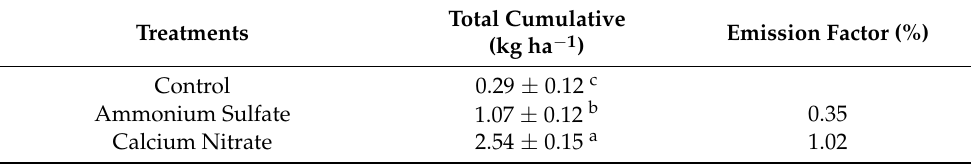
Table 2. Total cumulative N 2 O emission and the emission factor for 365 days.